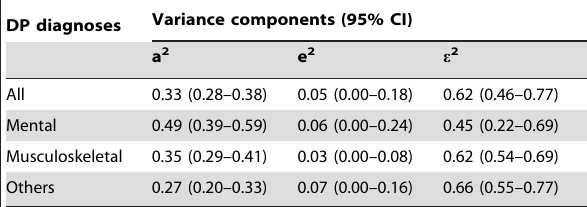
Table 5. Estimates of variance components of the best-fitting model (AE) for liability to disability pension (DP) due to all diagnoses, and DP by diagnostic group.